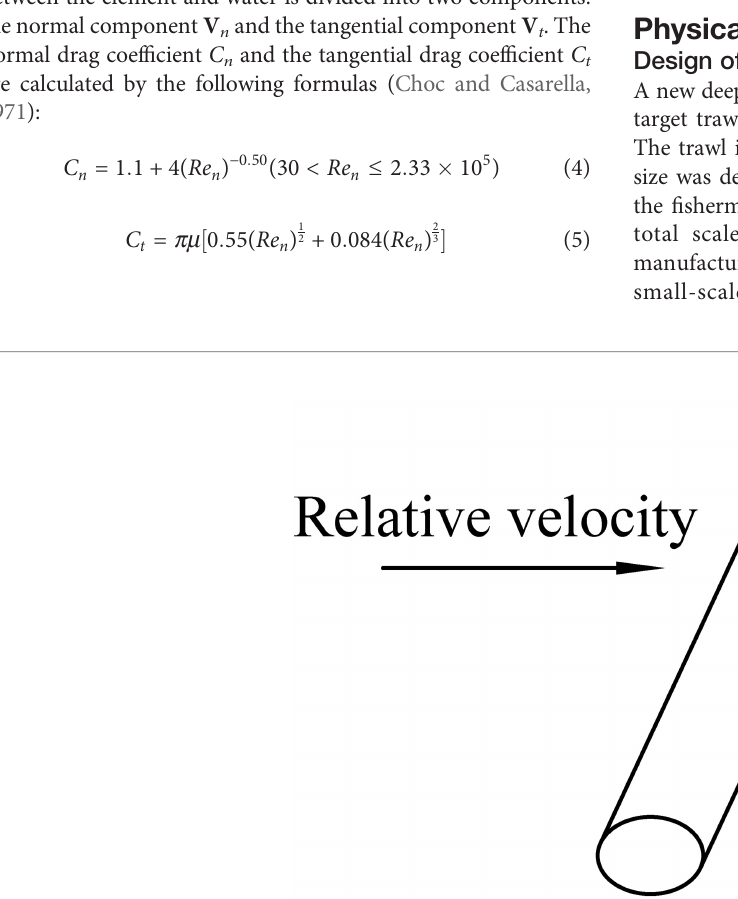
FIGURE 2 | Schematic diagram of the element position relative to